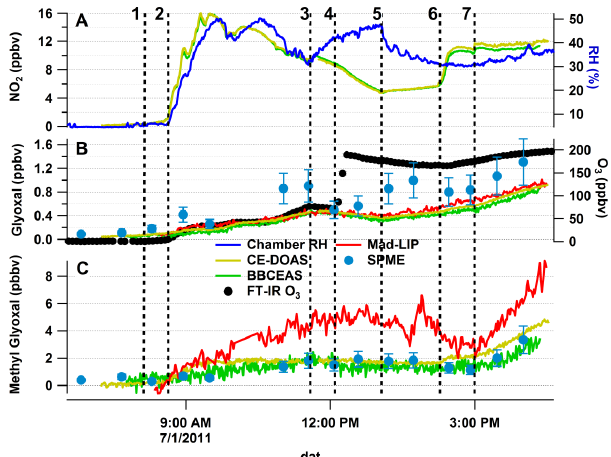
Figure 8. Ambient air experiment E6. (a) shows the NO 2 and rel- ative humidity, (b) glyoxal and ozone, and (c) methyl glyoxal. The chamber operations for the day were as follows: (1) at 8.05a.m. the chamber roof was opened; (2) the “chamber valve” was open from 8.37–9.30a.m., allowing ambient air to enter the chamber.